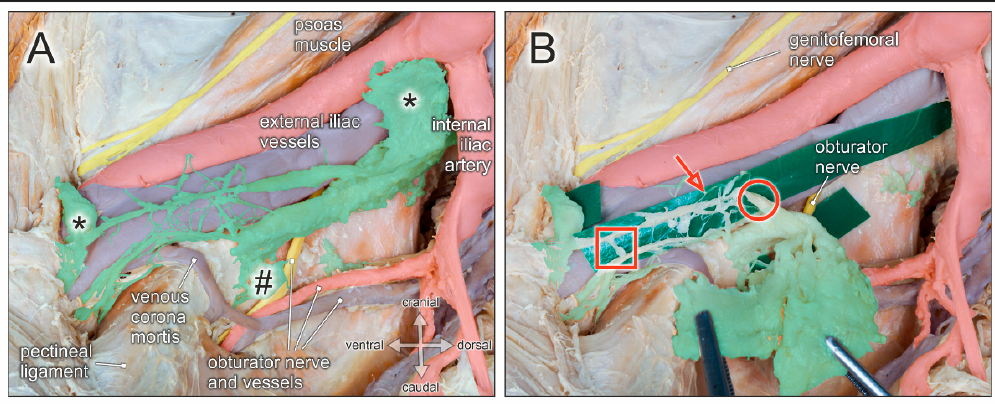
Figure 7. Lymph nodes and lymphatic vessels of the pelvic sidewall. Medial view of a right male hemipelvis. Pelvic organs, their blood vessels and autonomic nerves are shifted to the contralateral side; fatty tissue is removed. ( A ) External iliac lymph nodes (asterisks), obturator lymph nodes (hashtag), and interconnecting lymphatic vessels are highlighted (green). The obturator nerve is partly concealed by lymphatic tissue in the obturator fossa. Venous corona mortis is discernible. ( B ) The lymphatic tissue is partly pulled out of the obturator fossa en bloc (forceps). Green plastic strips are inserted to expose the morphological features of lymphatic vessels arranged in finely meshed networks extending between lymph nodes. Lymphatic vessels are of small (red arrow) and large (red circle) diameters, with rope ladder-like ramifications (red square), and susceptible to mechanical damage due to their thin walls.